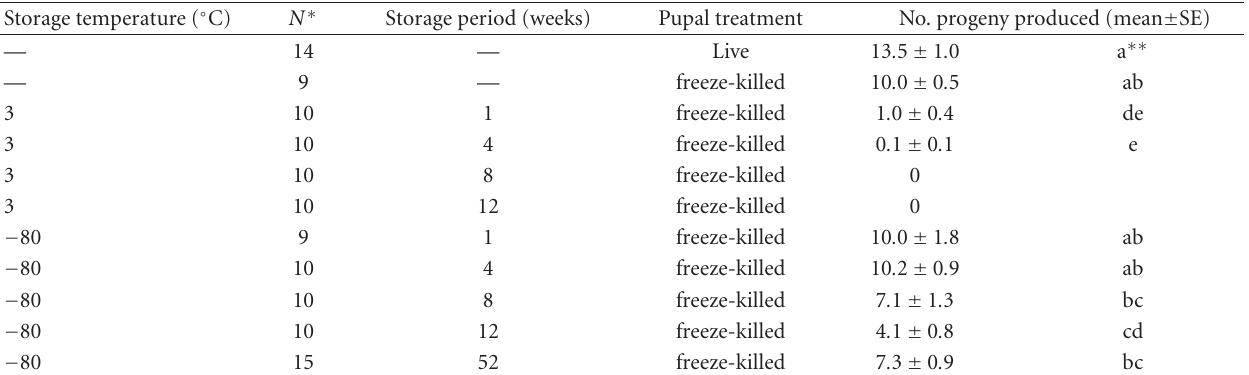
Table 4: Progeny production of S. endius on house fly pupae treated with di ff erent temperatures and storage periods after cold treatment. Storage temperature ( ◦ C) N ∗ Storage period (weeks) Pupal